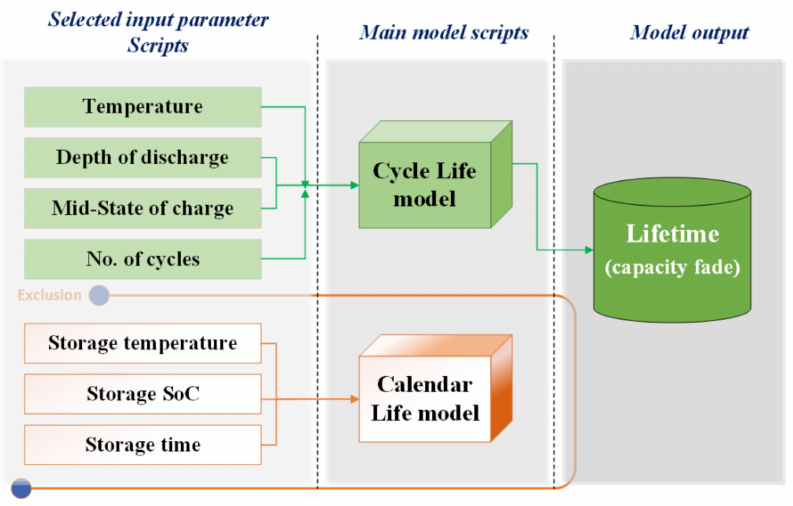
Figure 2. Schematic overview of the adapted lifetime